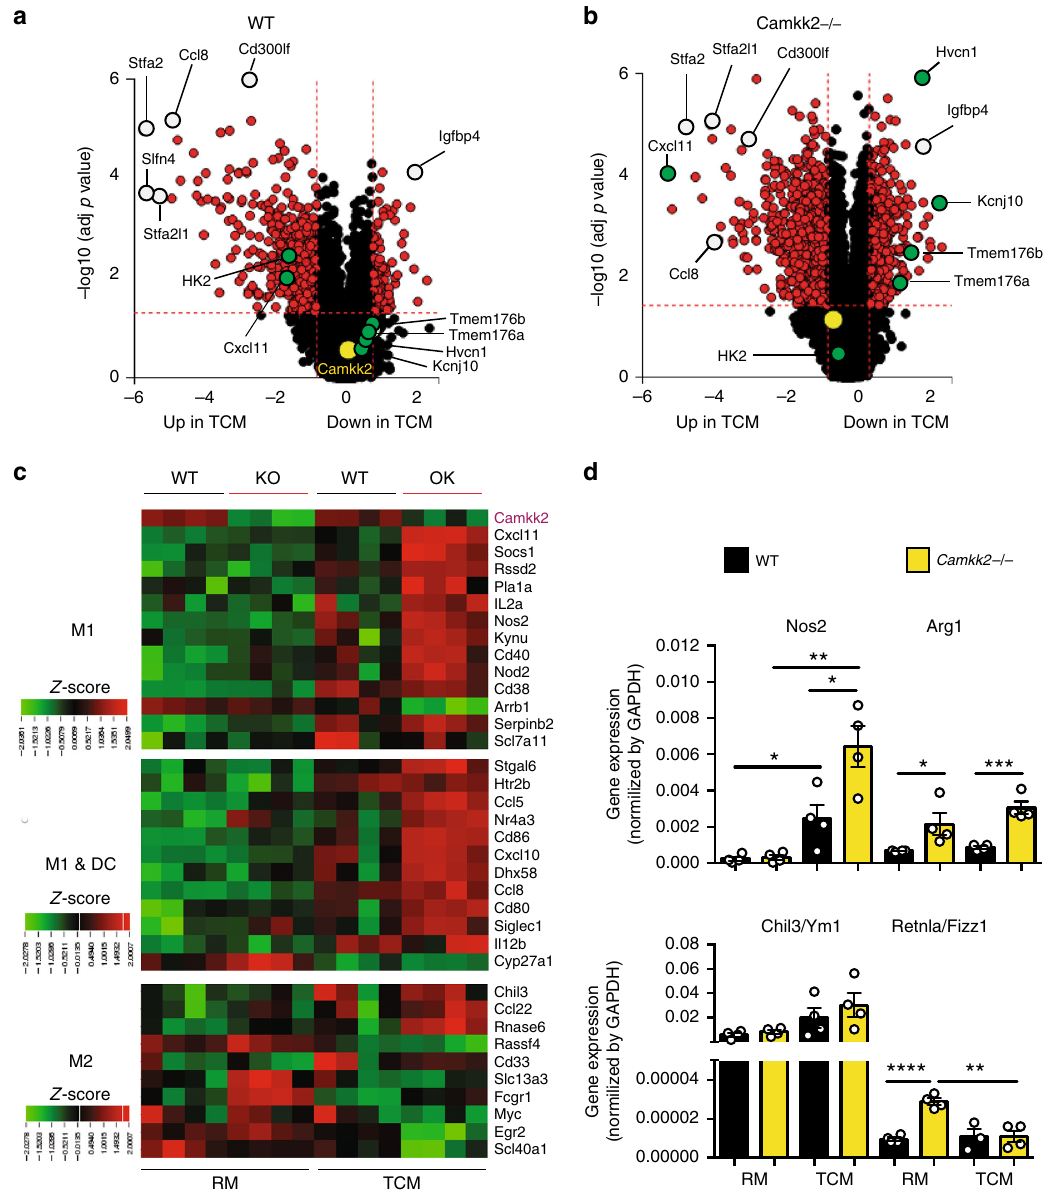
Fig. 4 CaMKK2 regulates gene transcription in BMDM. Bone marrow-derived macrophages (BMDM) were generated from WT and Camkk2 − / − mice in the presence or absence of E0771-conditioned medium (RM and TCM, respectively). Subsequently, BMDM was harvested and analyzed for gene expression. N = 4 biological replicates/group. a , b Volcano plots of differentially expressed genes (DEGs) in WT (left) and Camkk2 − / − (right) generated in the presence of RM or TCM. Open circles indicate genes showing comparable expression levels in WT and Camkk2 − / − BMDM. DEGs between WT and Camkk2 − / − BMDM are shown as green fi lled circles. Yellow open circles refer to the Camkk2 gene. c Heatmaps of DEGs af fi liated with M1, M1 and dendritic cells (M1&DC), or M2 signatures. The color key for the heatmap indicates (row-wise) scaled RPKM values (z-score). d Real-time quantitative PCR (qPCR) analysis of genes associated with M1 ( Nos2 ) and M2 ( Arg1 , Chil3/Ym1 and Retnla/Fizz1 ) gene signatures (four biological replicates were analyzed for each genotype). A t test was used to calculate p -values. The data are graphed as the mean ± SEM. Asterisks refer to * p < 0.05, ** p < 0.01, *** p < 0.005, and **** p < 0.001. This experiment was replicated at least three times with similar